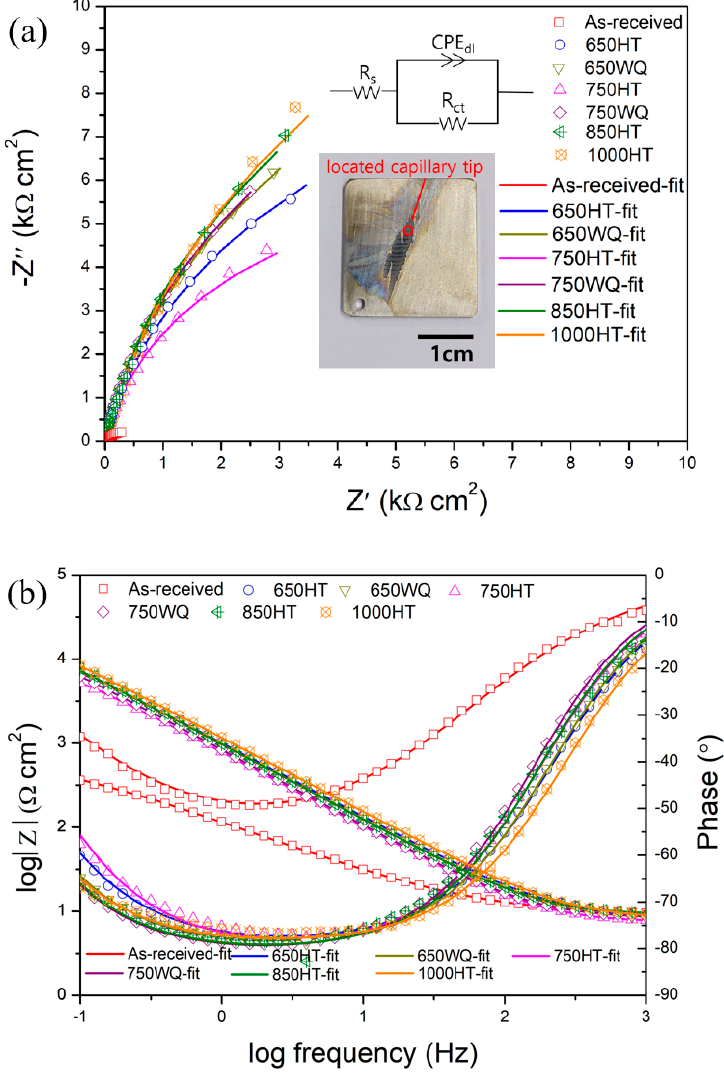
Figure 12. ( a ) Nyquist and ( b ) Bode plots of EIS for the corroded samples after E-CLCT for the as-received, HT, and WQ samples of AM Ti–6Al–4V alloys in Ringer solution. The insets show the equivalent circuit for fitting and the optical micrograph with the location of capillary tip in microdroplet cell, respectively (HT: furnace cooling; WQ: water quenching). Table 3. Fitting parameters of the EIS measured in Ringer solutions for the as-received and heat-treated AM Ti–6Al–4V alloys after E-CLCP tests.